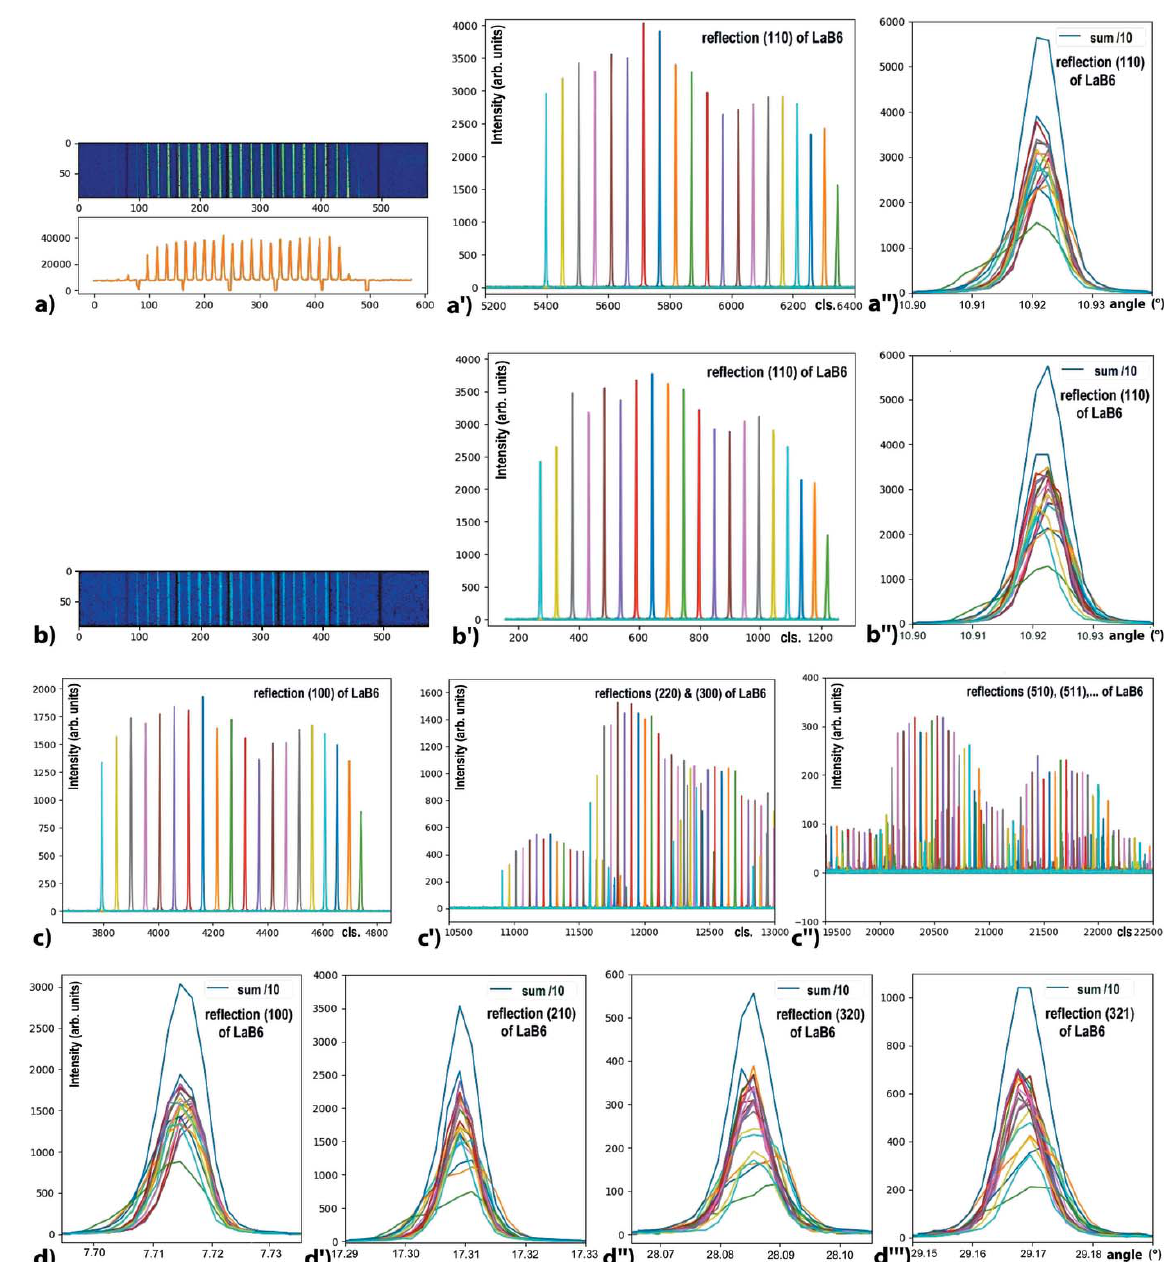
Figure 4 Intensities of diffraction reflections of a LaB 6 reference powder, collected on the D2AM beamline goniometer with a 0.4 mrad quasi-parallel beam of size 80 m m (cid:7) 150 m m and an energy of 22 keV, filtered by the two single-crystal-comb and Soller-collimator blocks, with an angular pitch of 0.1 (cid:2) between the Si(111) crystals. ( a ) Signals from the (110) reflection of LaB 6 , received by the XPAD S70 detector, which visualizes the 20 beams filtered by the single- crystal-comb. ( a 0 ) Intensities of the 20 signals filtered by each Si(111) analyser crystal for this (110) reflection (with a different colour for each analyser crystal). ( a 00 ) Superposition of these 20 filtered intensities and their sum (divided by 10). ( b , b 0 , b 00 ) Signals received by the 2D detector and profiles of these 20 beams filtered by each Si(111) analyser crystal for the same (110) reflection which was measured several days later, after data collections made with the same system on several other samples; we note a good constancy of the intensities of each of the beams filtered by each analyser crystal. ( c , c 0 , c 00 ) Intensities of the diffracted lines filtered by each Si(111) analyser crystal at different Bragg angles corresponding to the LaB 6 reflections: ( c ) (100), ( c 0 ) (220) and (300) and to ( c 00 ) weak high angles reflections. ( d , d 0 , d 00 , d 000 ) Superpositions of the 20 diffracted intensities filtered by each Si(111) analyser crystal of the single-crystal-comb, and their sum (divided by 10), for the LaB 6 reflections (100), (210), (320) and